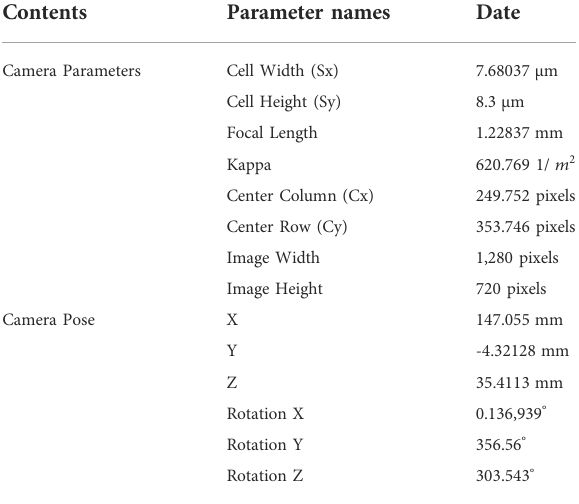
TABLE 3 Camera parameters& Camera